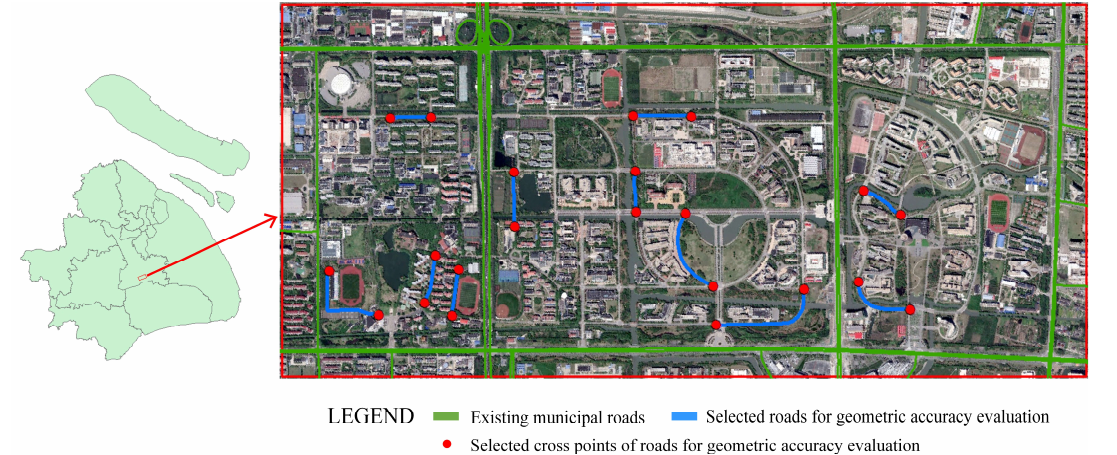
Figure 8. The location, imagery, existing municipal roads of the case area, and selected roads and cross points for quality evaluation. The imagery was collected on 13 April 2017 by DigitalGlobe’s GeoEye-1. The spatial resolution of the imagery was 1 m. The imagery was matched to real map by the georeferencing toolbar of ArcGIS software. Relative to the real map, the 13 control points of the image had a positional accuracy of 1.97 m RMSE (error magnitudes range from 1.35 to 2.93 m).